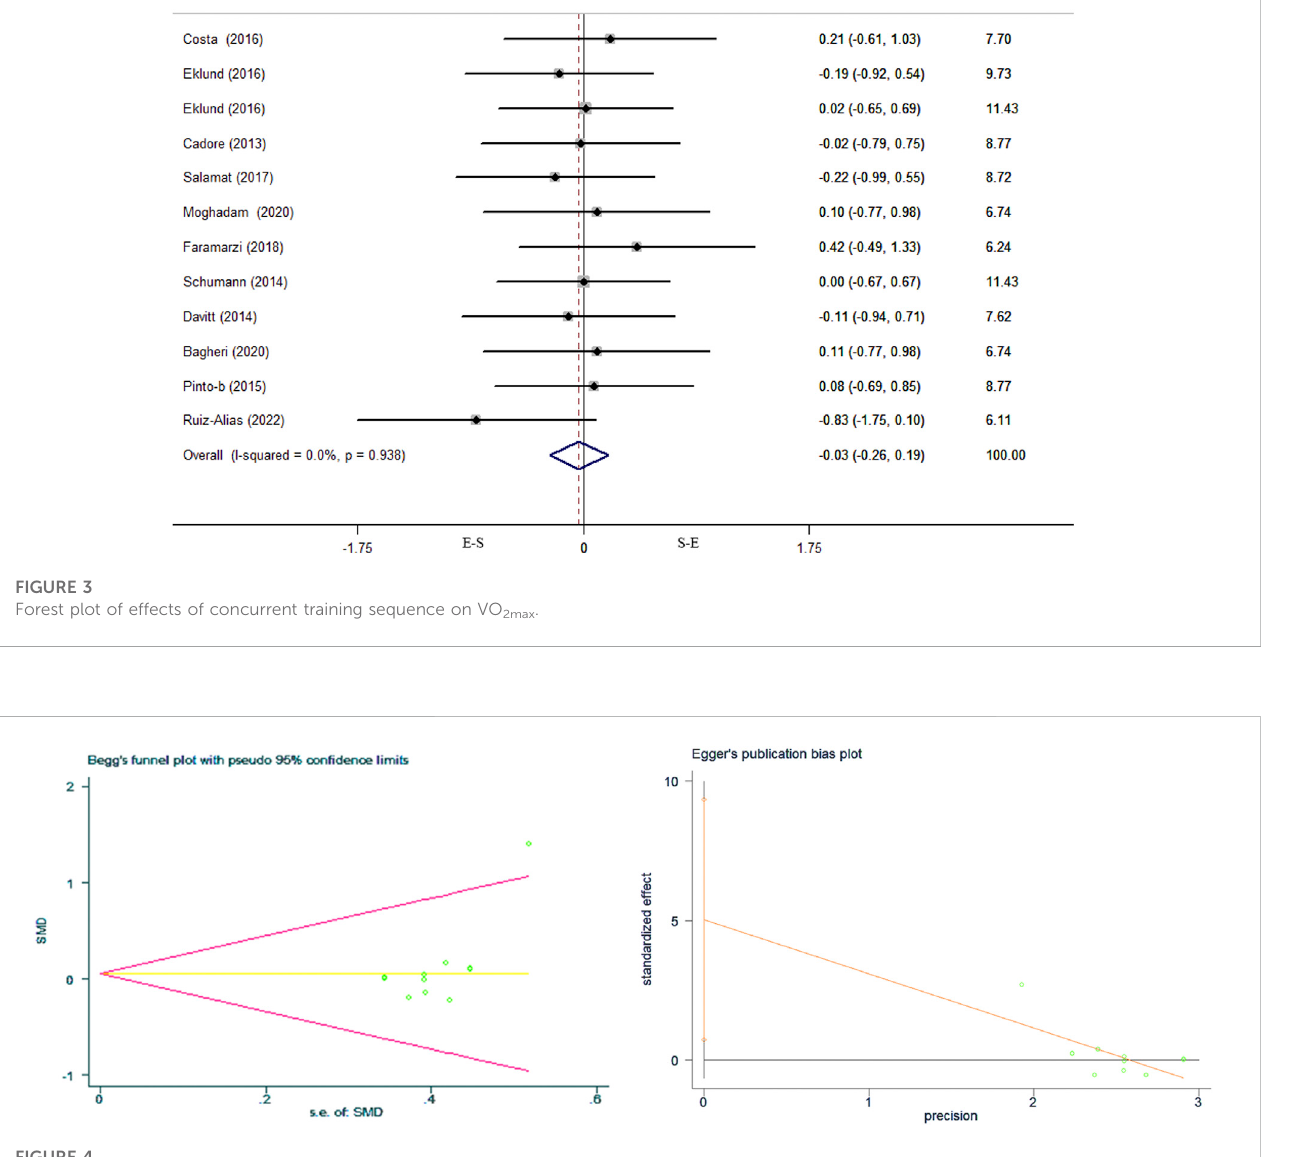
FIGURE 4 Bias analysis of the impact of concurrent training sequence on VO 2max